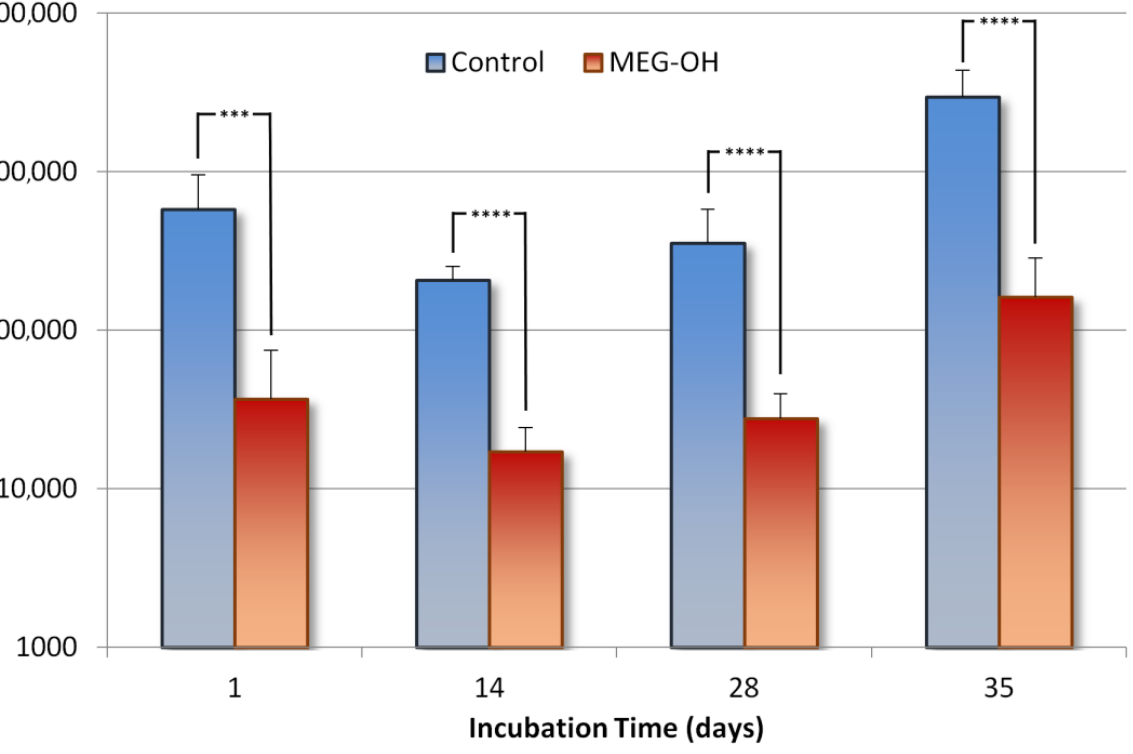
Figure 2. Comparison of CFU counts of E. coli growing on control (blue) and MEG-OH coated (red) polyurethane surfaces at days 1 (static culture), 14, 28, and 35 (under flow of 2 g/L LB medium). Asterisks represent the calculated confidence interval using a two variable t -test (* = 90%, ** = 95%, *** = 98%, and **** = 99%+, n = 6).